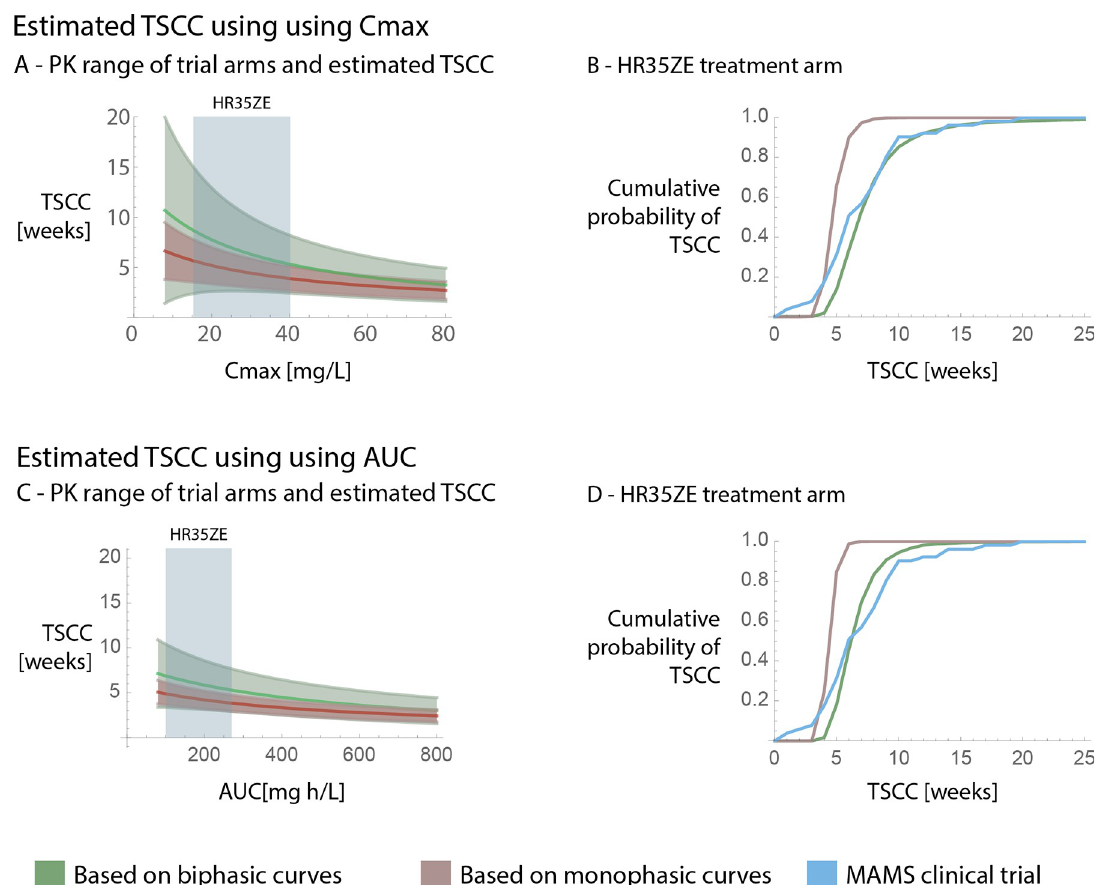
Fig 6. Estimated TSCC based on the statistical analysis, and comparison to measured TSCCs in a multi arm multi stage (MAMS) clinical trial (NCT01785186, [30]). Here, the green curves show estimates based on biphasic curves (i.e taking the slowdown in decline into account), while red shows estimation based on monophasic curves (i.e. neglecting the possibility of a slowdown in decline). Blue always corresponds to data from the MAMS clinical trial. Fig 5A and 5C show the dependence of the predicted TSCC on the pharmacokinetic parameters (Cmax and AUC respectively), as well as the measured pharmacokinetic ranges for the HR35ZE treatment arm of the MAMS clinical trial used for comparison (blue boxes). Here, the area around the estimates signify the 95% confidence interval around our estimates. The estimates are only shown within the parameter ranges of the EBA clinical trial. Fig 5B and 5D show the cumulative probability (Y-axis) of TSCC (X-axis) based on the estimates within the PK ranges of the MAMS trial as well as the data from the MAMS trial